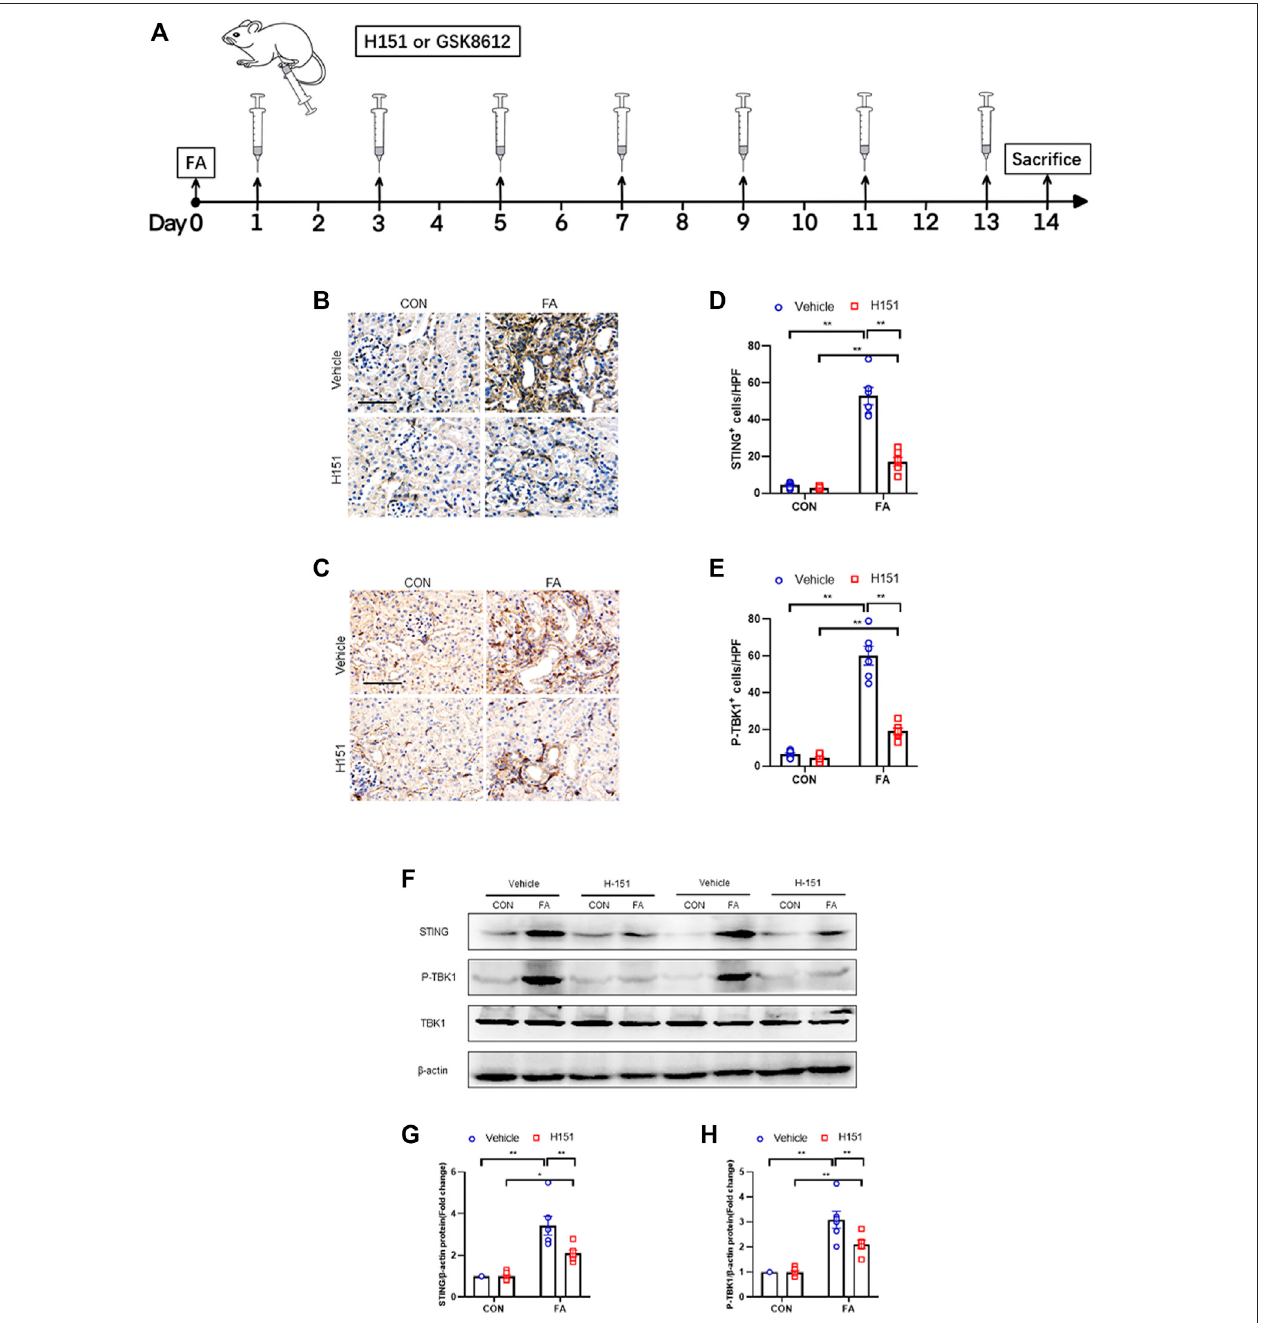
FIGURE 1 | STING/TBK1 signaling pathway is signi fi cantly activated in FA nephropathy. (A) Timeline diagram of experimental model. (B,C) Representative photomicrographs of kidney sections in each group stained for STING (brown) or p-TBK1 (brown). (D,E) Quantitative analysis of STING or p-TBK1 positive cells in the kidneys. (F) Representative western blots show STING and TBK1 protein levels in the kidneys in each group. (G,H) Quantitative analysis of STING and TBK1 protein expression in the kidneys. ** p < 0.01, * p < 0.05; n = 6 in each group; Scale bar: 50 μ m.